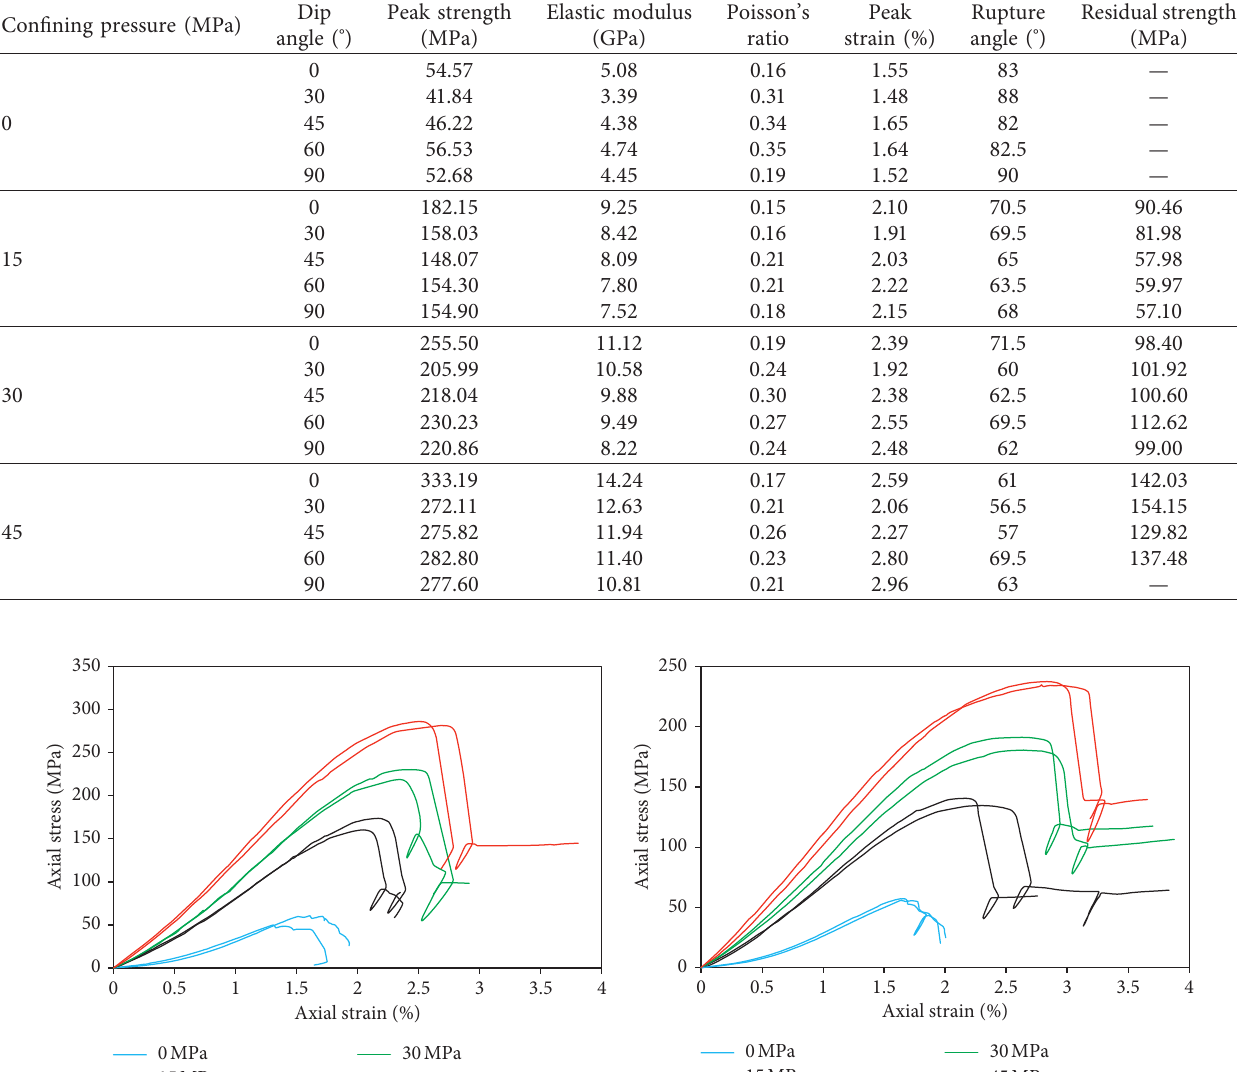
Table 2: Triaxial compression testing results of samples with different strata angles.